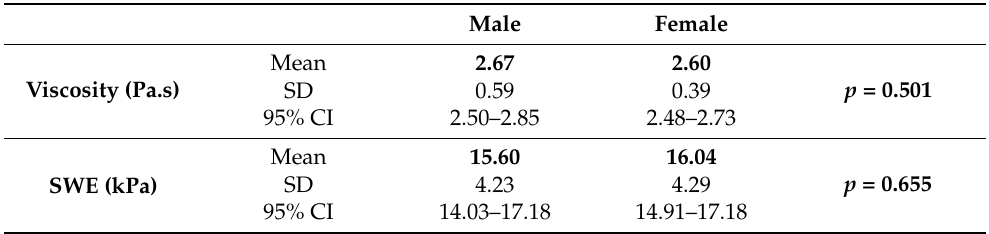
Table 4. Mean viscosity and stiffness values of the thyroid parenchyma in the healthy volunteers group according to gender.